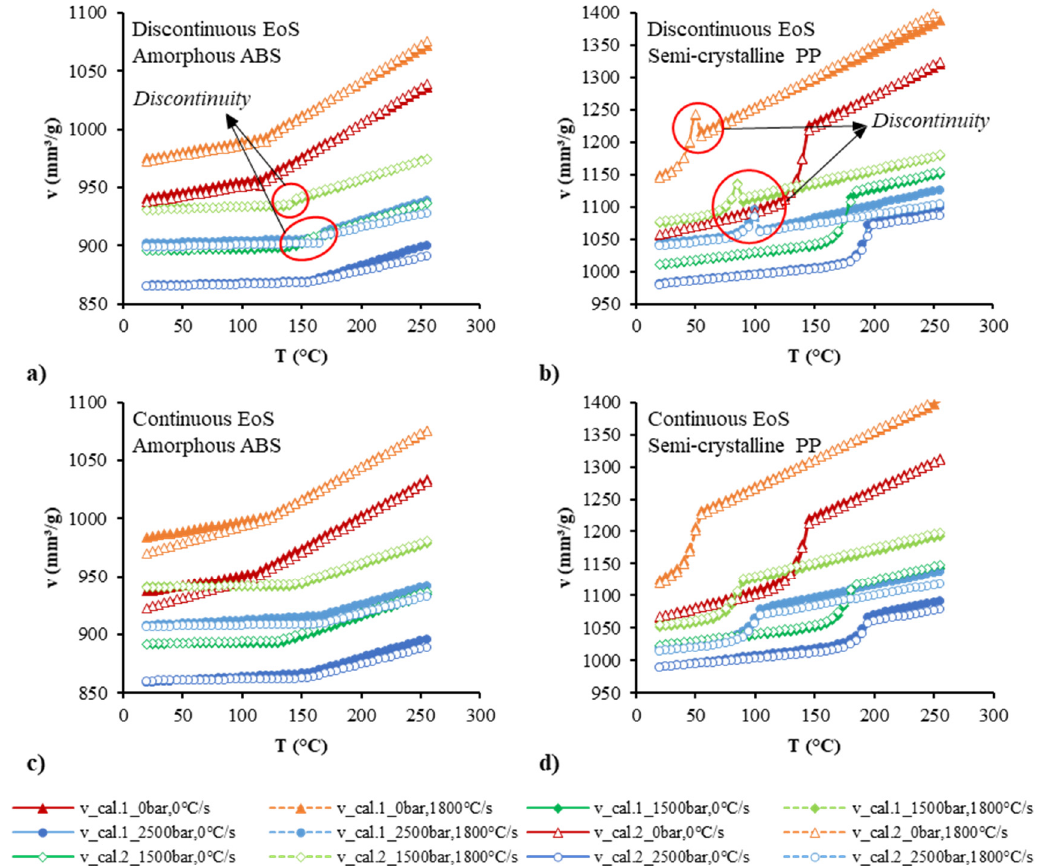
Figure 12. Predicted specific volume as a function of temperature, pressure, and cooling rate by the discontinuous two-domain EoS for amorphous polymers ( a ) and semi-crystalline polymers ( b ) and the continuous two-domain EoS for amorphous polymers ( c ) and semi-crystalline polymers ( d ).